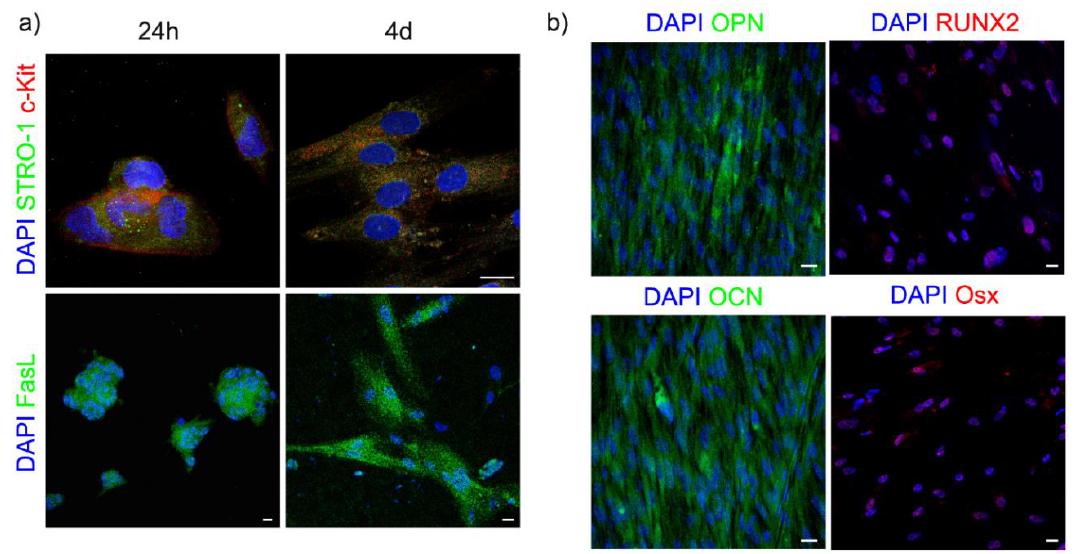
Figure 4. ( a ) Evaluation of stemness markers and FasL expression in hDPSCs cultured on BGMS10 at 24 h and 4d. ( b ) Osteogenic differentiation of hDPSCs after 21 days of induction on BGMS10 surfaces. Scale bar: 10 μm.